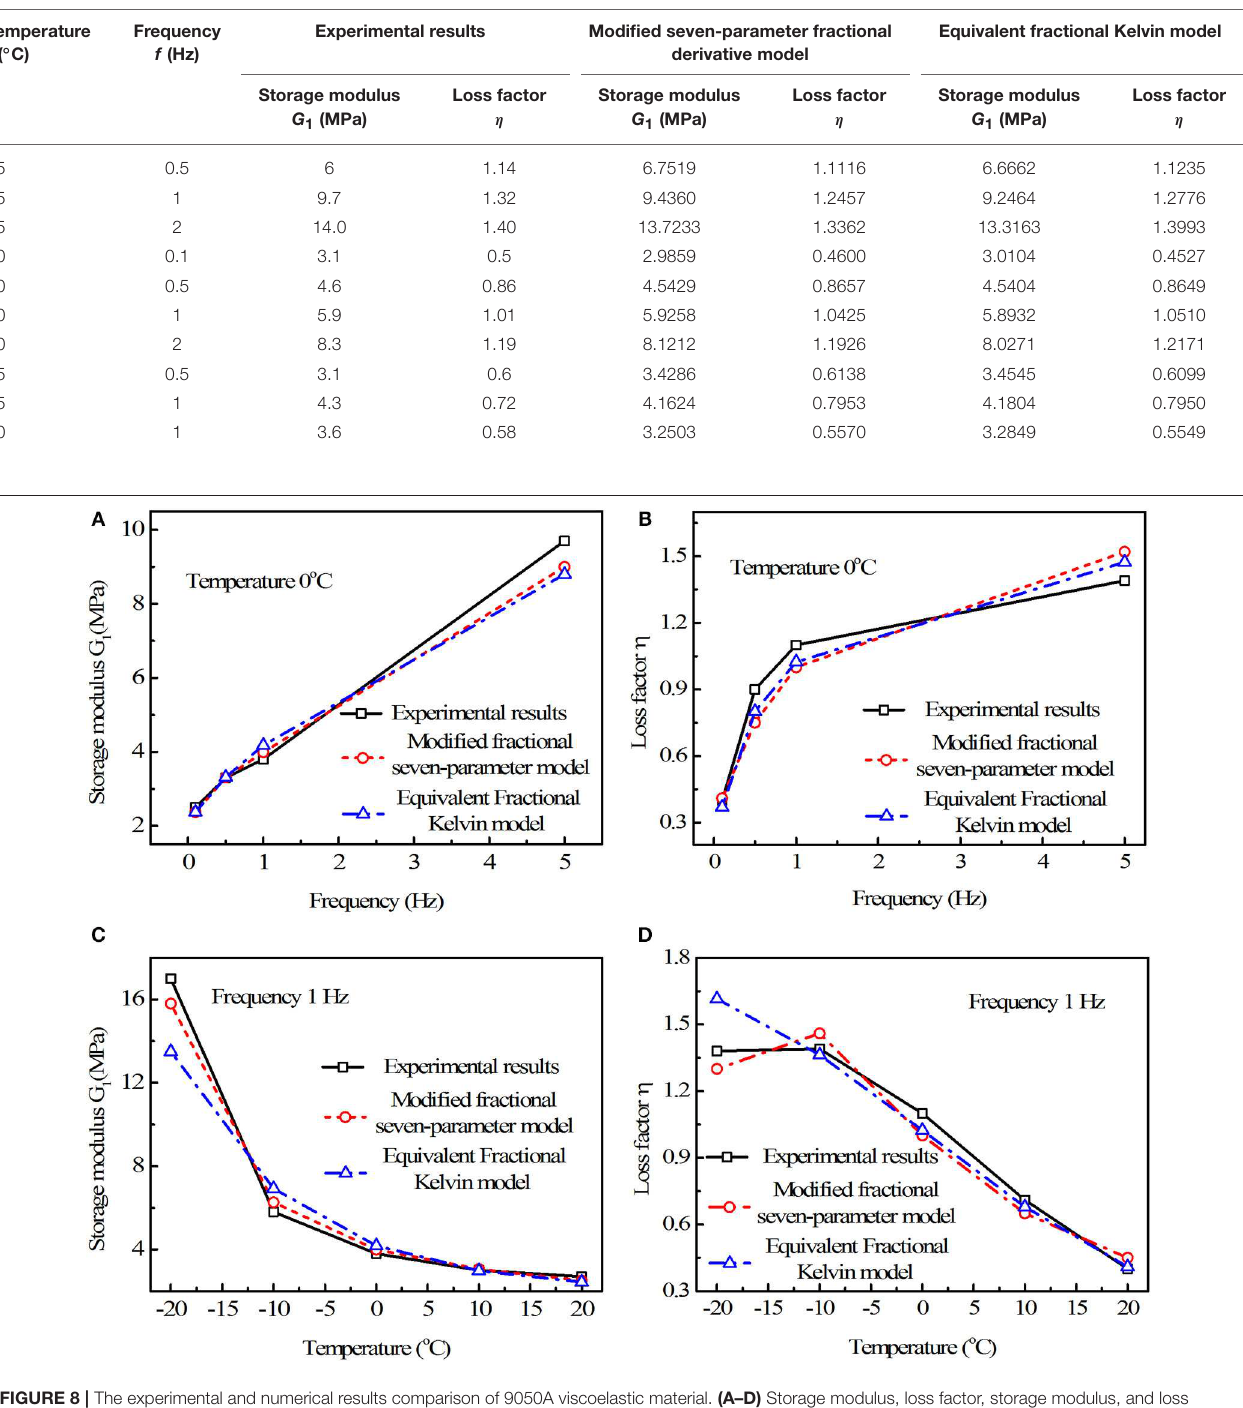
validate the modified seven-parameter fractional derivative model. Finally, some notable conclusions can be